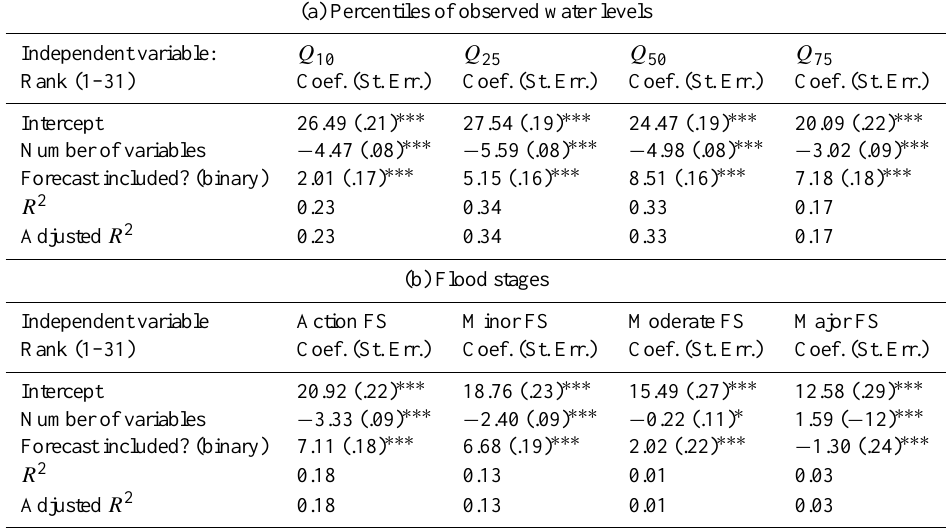
Table 2. Results of regression analyses to determine the impact of including more variables and the forecast into the joint predictor.